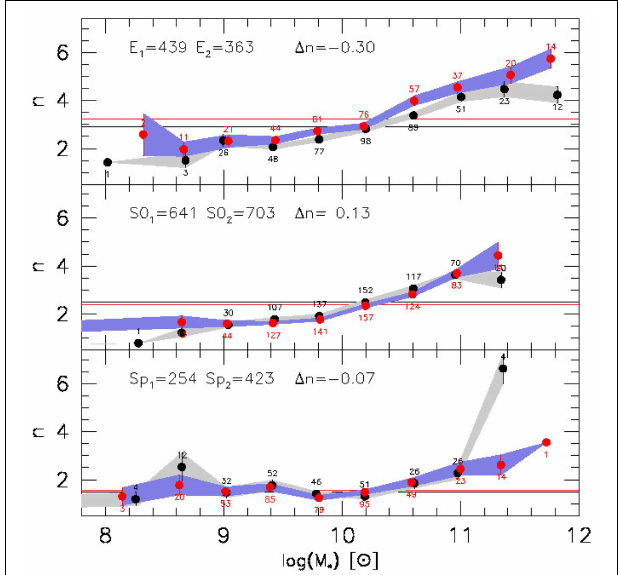
FIGURE 16 | The Sérsic index as a function of galaxy stellar mass for the three morphological types in two different regimes of cluster-centric distances. Black dots mark the values for D BCG / R 200 while red dots those for D BCG / R 200 > 0 . 3